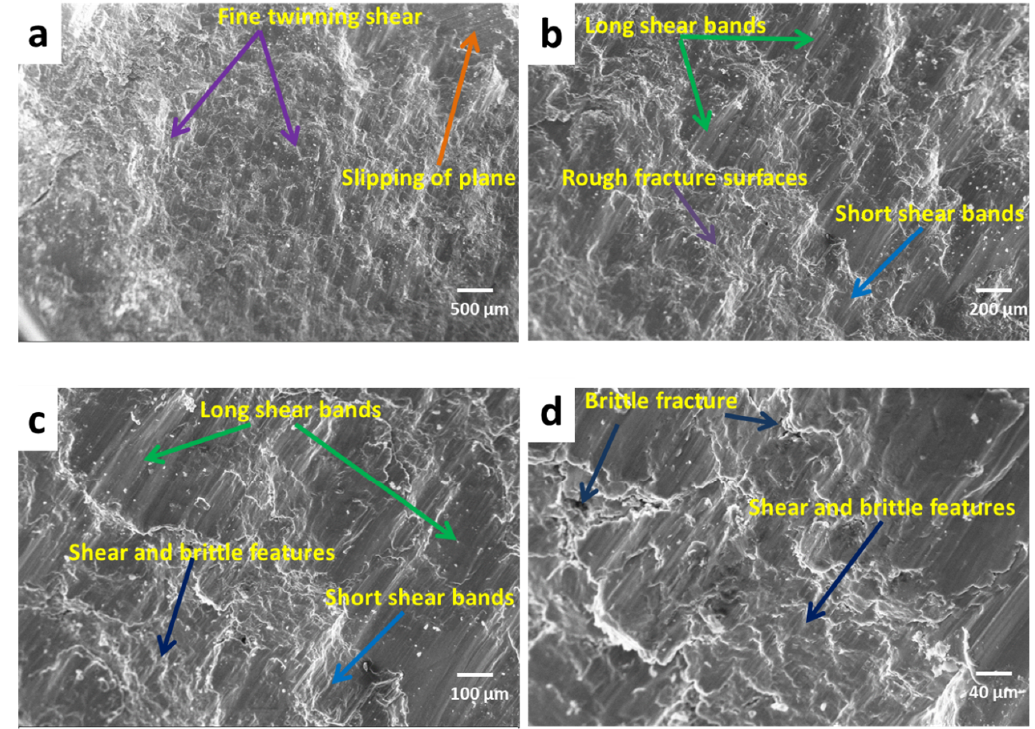
Figure 11. SEM compressive facto-graph of AZ91 at different magnifications: ( a ) 41×, ( b ) 100×, ( c ) 200×, ( d ) 500×.